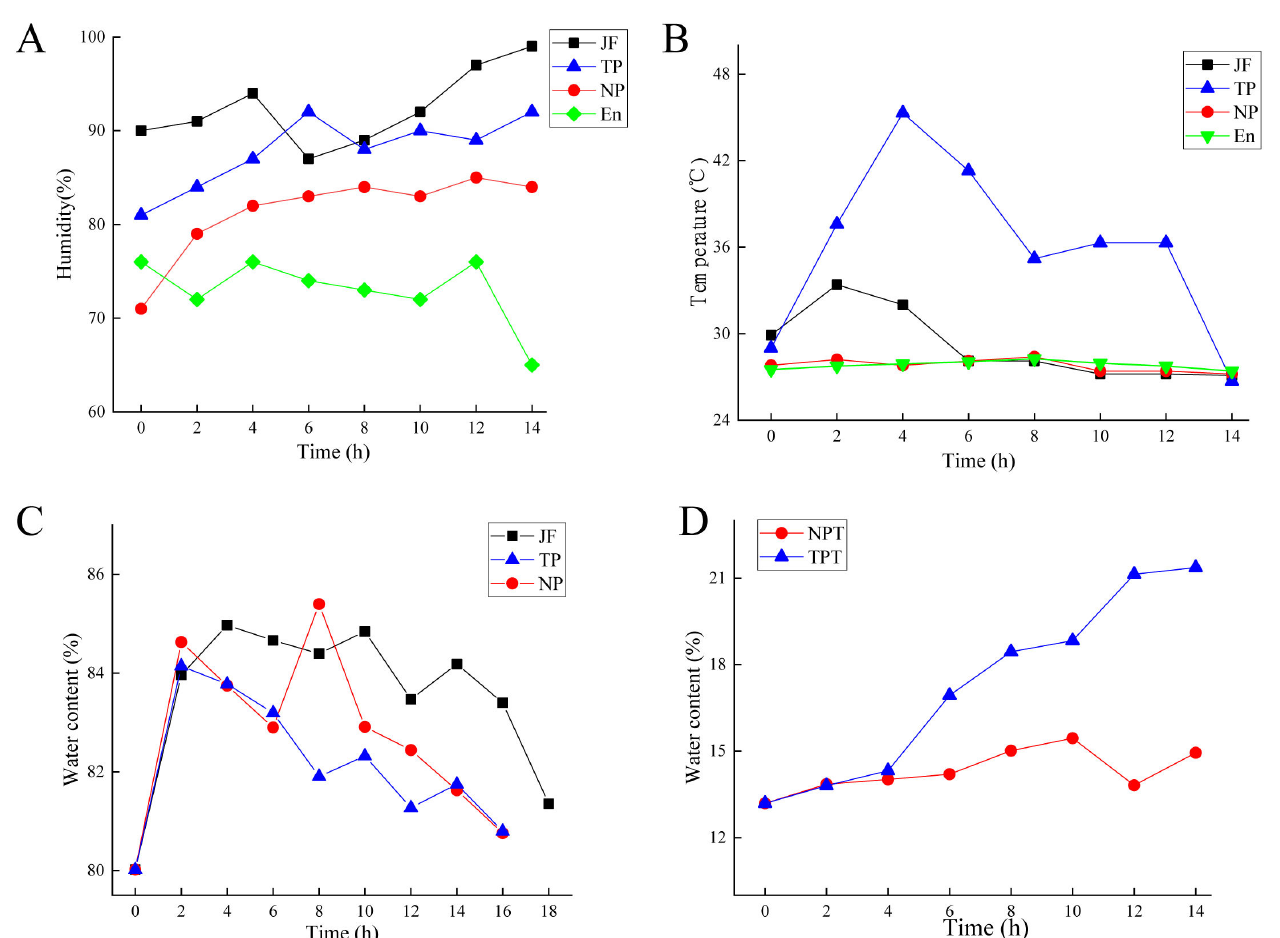
Figure 1. The change during scenting process. ( A ) humidity change of jasmine. ( B ) temperature change of jasmine. ( C ) water content of scented jasmine. ( D ) water content of jasmine tea. JF: jasmine flower; NP: jasmine flower in the new scenting process; TP: jasmine flower in the traditional scenting process; NPT: jasmine tea in the new scenting process; TPT: jasmine tea in the traditional scenting process; En: